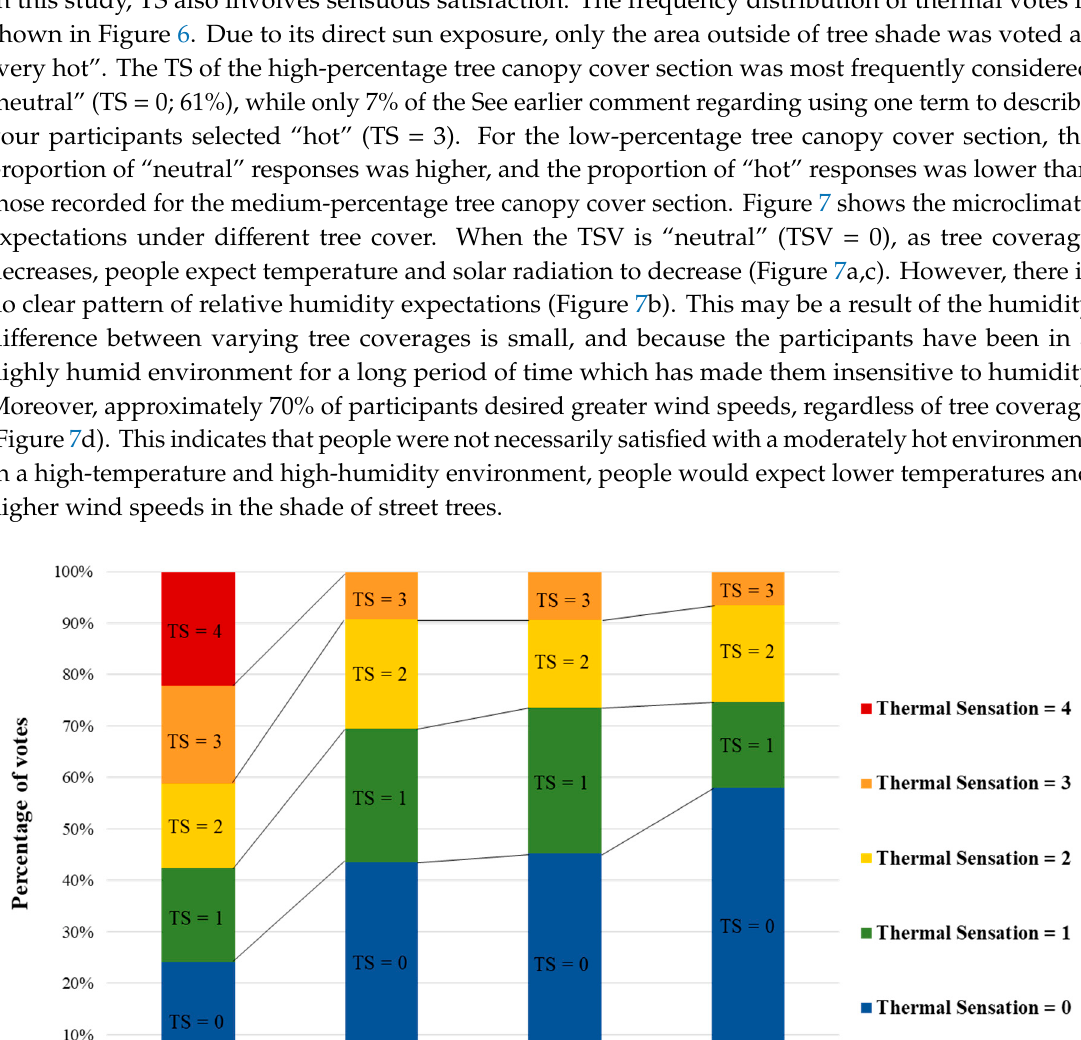
Figure 6. Distribution of thermal sensation votes across different degrees of tree canopy cover.